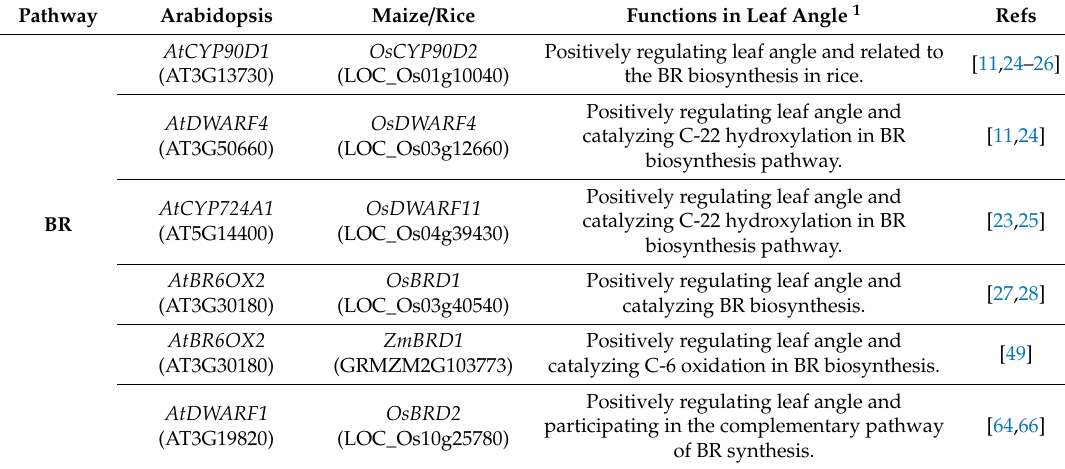
Table 1. Cloned genes associated with leaf angle in rice and